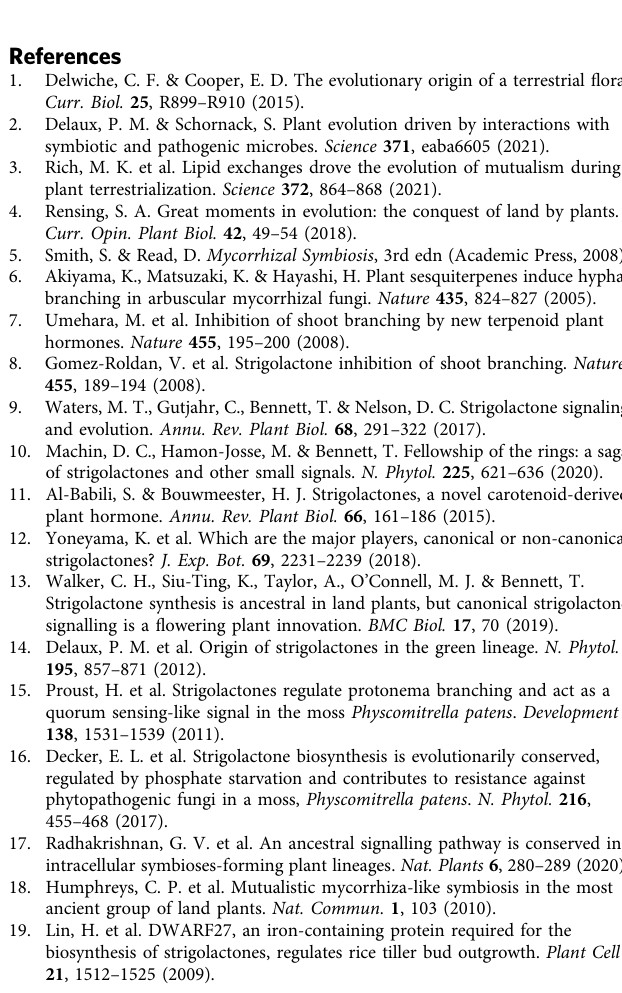
Table 5. Transcriptome data were deposited in the DDBJ and are available through the Sequence Read Archive (SRA) with the identi fi er DRA012476. LC-MS/MS data were deposited in Metabolights with the identi fi er MTBLS5064. The authors declare that all data supporting the fi ndings of this study are available within the manuscript and its Supplementary fi les or are from the corresponding author upon request. Source data are provided with this